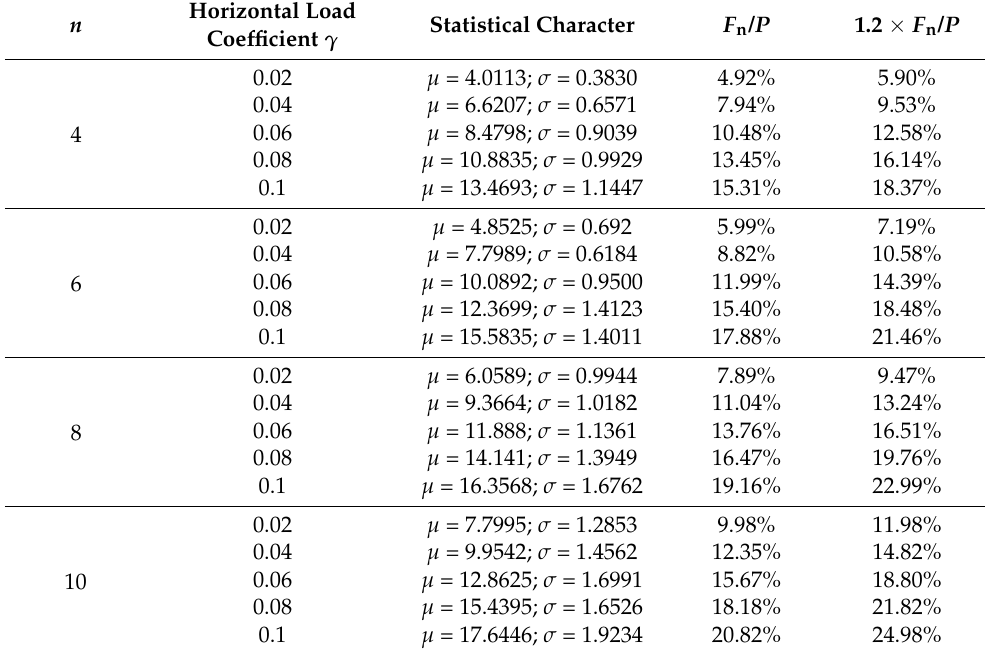
Table 5. Statistical results of ( F / P ) × 100 and F n / P * under the most unfavorable horizontal load